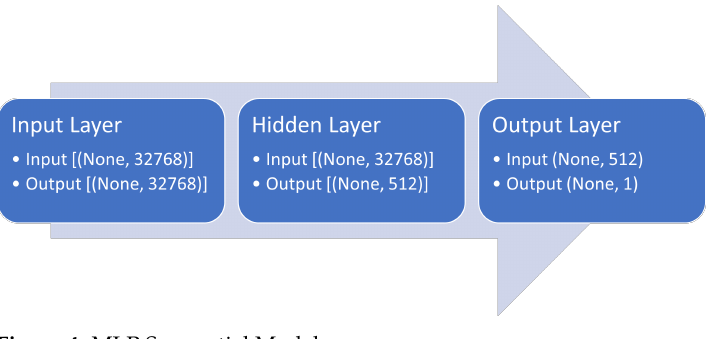
Figure 4. MLP Sequential